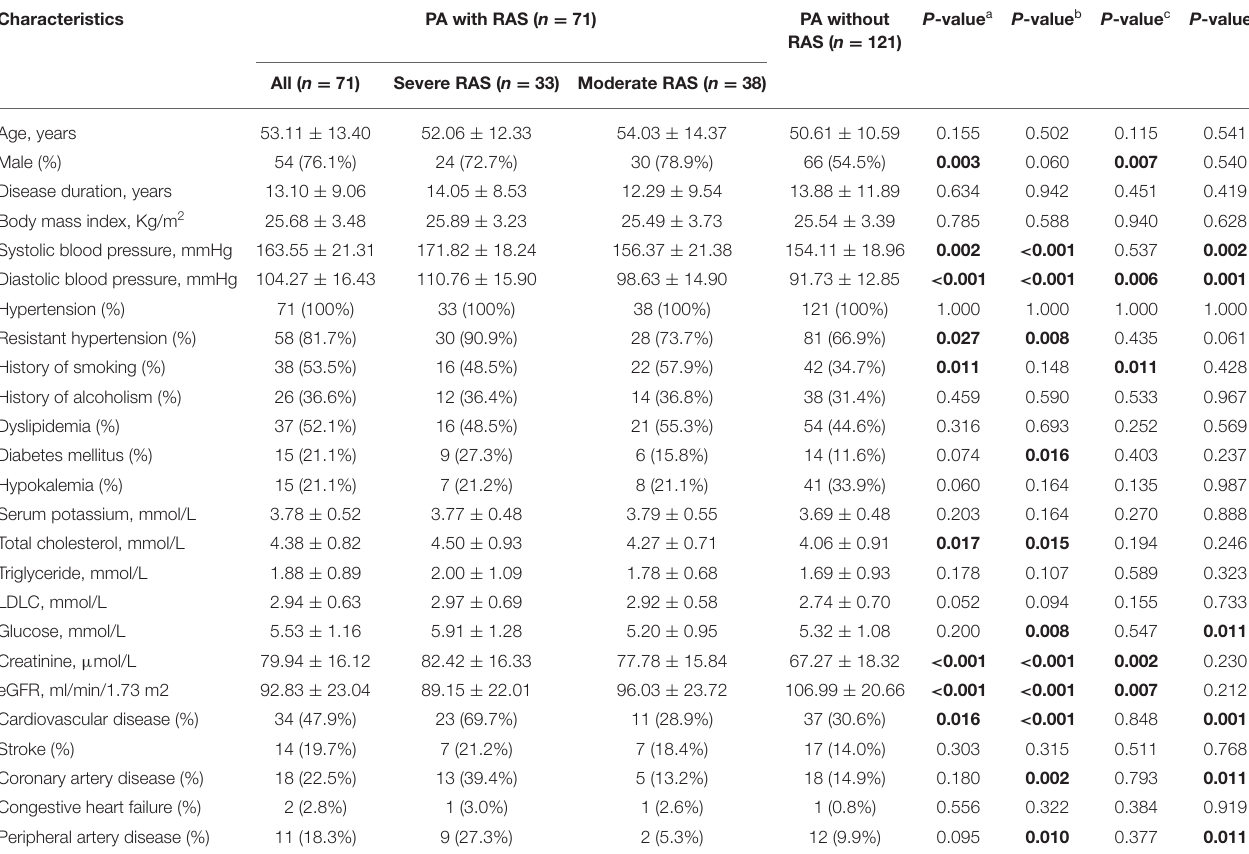
TABLE 1 | Medical records of the subjects in the PA with RAS group and PA without RAS group at baseline.